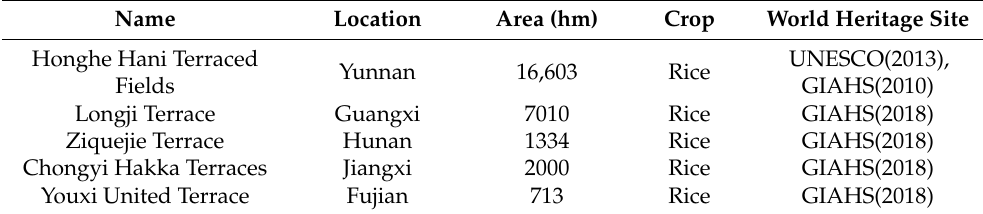
Table 3. Main terraces in China.